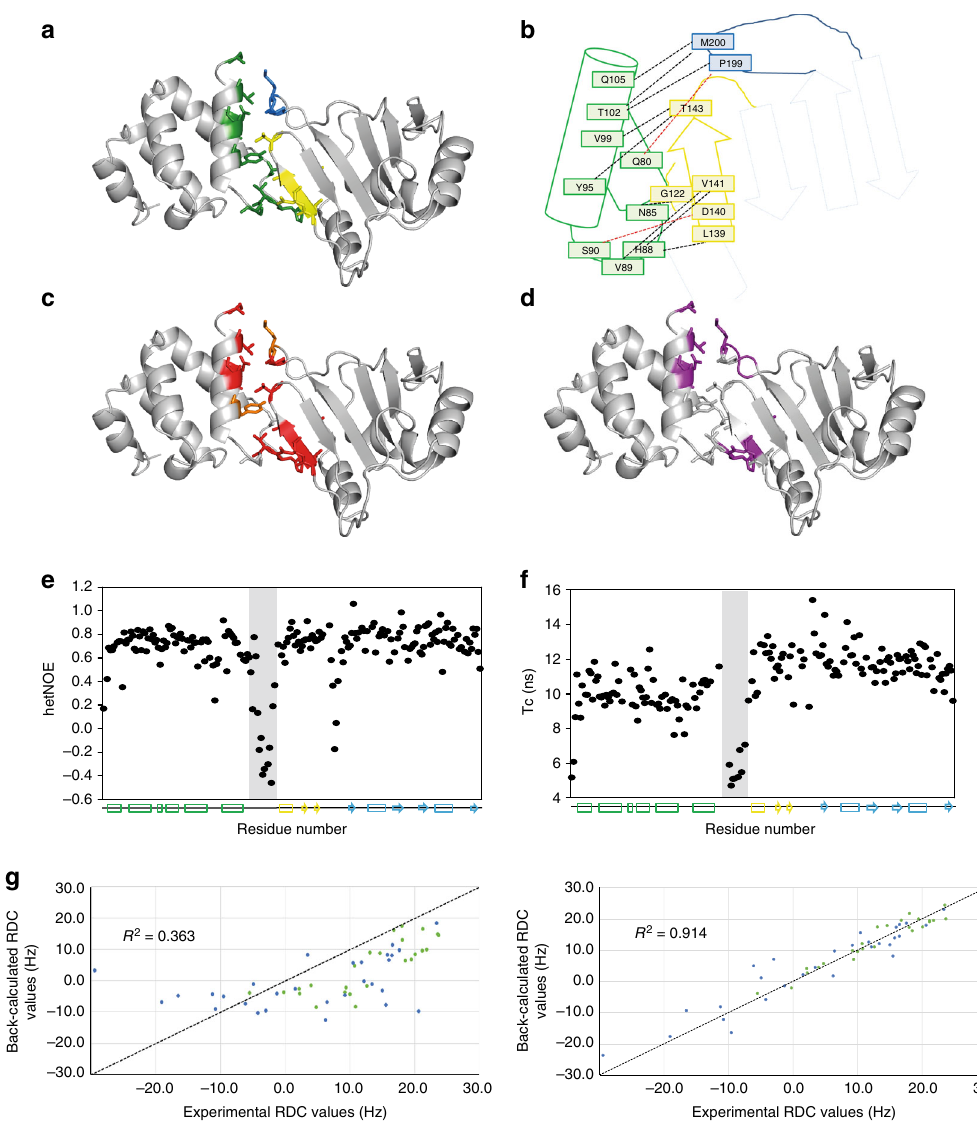
Fig. 4 Syncrip N-terminal and extended RRM1 domains are coupled by a speci fi c and dynamic interface. a Cartoon representation of the structure of Syncrip N-terminal region (NeR1). The side chains of the amino acids mediating the inter-domain interaction are displayed as sticks and coloured in green (N-terminal domain), yellow ( αββ extension) and blue (RRM core domain). b Schematic of the inter-domain contacts using the same colour coding as in panel a . Dashed lines represent the interactions between residues. Hydrophobic interactions are in black, hydrogen bonds in red. c Conservation of the inter-domain interface. Residues conserved in Drosophila and human are coloured in red (identical) or orange (same residue type). d Amide resonances of either domain that change in the context of two-domain construct are coloured in purple on the NeR1 structure. The changes observed are limited to the interaction surface observed in the crystal, indicating that the conformation observed in the X-ray structure represents the major conformer in solution. e Heteronuclear NOE and f rotational correlation time ( τ c ) values mapped along the protein ’ s sequence. The secondary structure is drawn at the bottom of each panel. The trend of NOE and τ c values along the sequence indicates that two domains are stably folded while amino acids in the inter-domain linker (grey background) and in the loop between the canonical fold and αββ extension of the RRM are more fl exible. The different τ c values indicates that the two domains do not tumble together. g Correlation between experimentally measured RDCs, and RDCs back-calculated from the crystal structure using the programme Module. In the left-hand panel a single tensor was used to fi t the data, while in the right-hand panel two tensors corresponding to the two domains (green: N-terminal domain blue: extended RRM1) were used in the fi t. The two-tensor fi t shows a much better correlation with the data (the correlation coef fi cient between measured and calculated RDCs was 0.914 instead of 0.363) con fi rming that the two domains do not behave as a single stable structural unit in